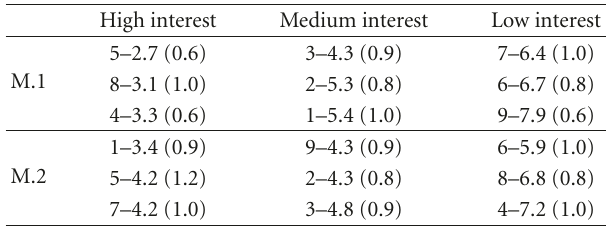
Table 5: Interest categories for the two mosaics of Figure 6 based on the observers’